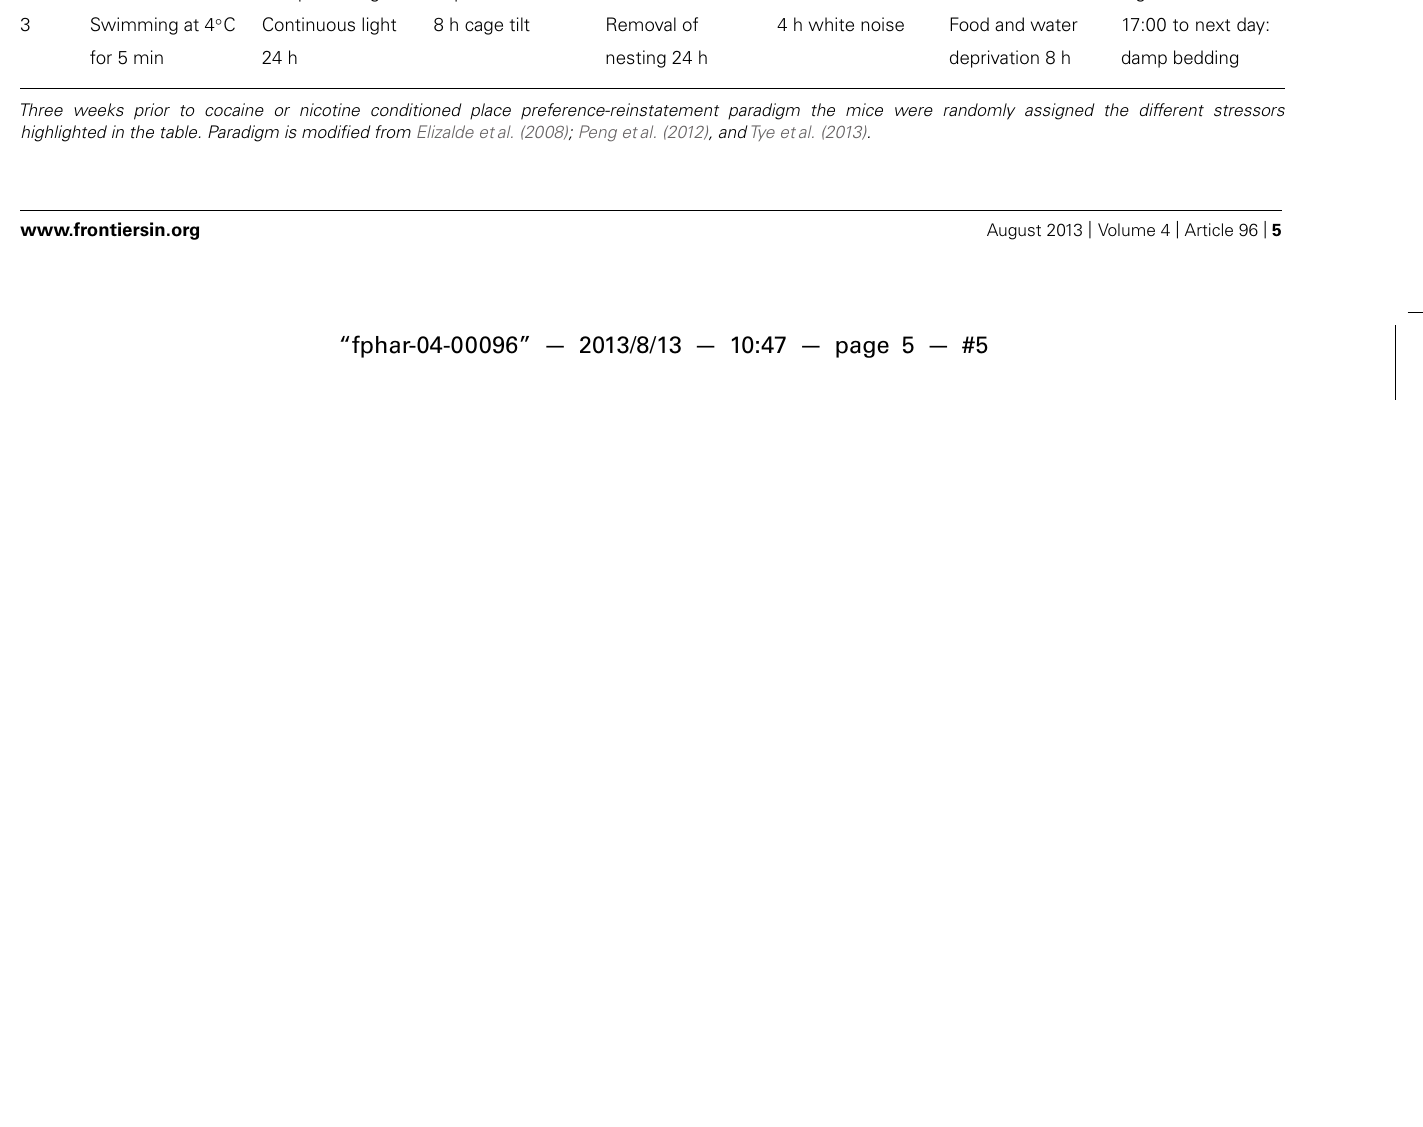
Table 1 |Three-week chronic mild stress schedule.